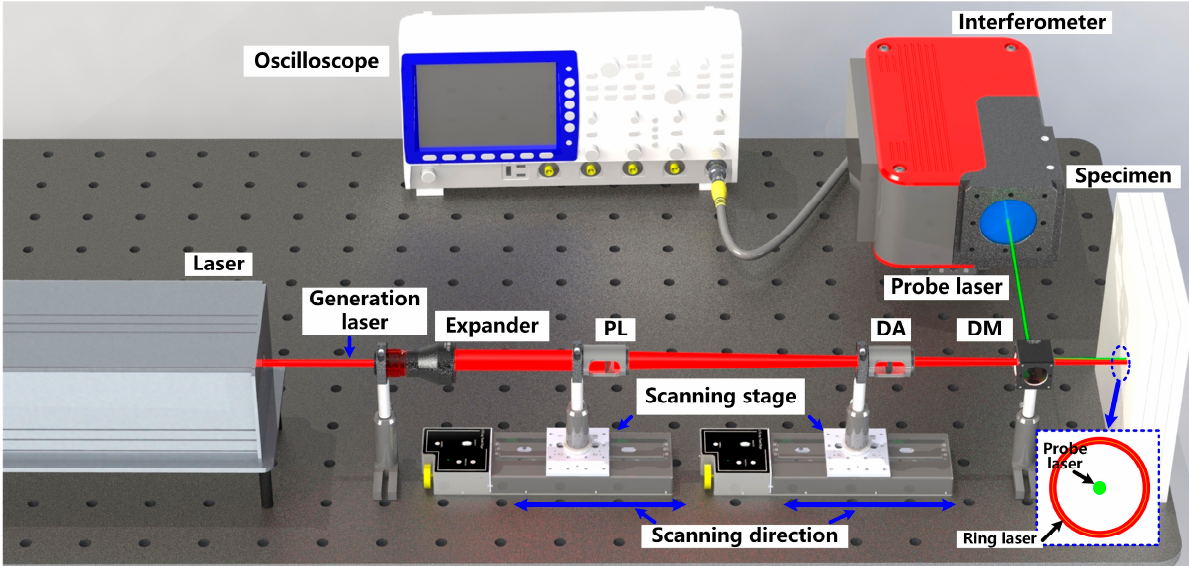
Figure 2. Schematic diagram of RLUT system for thickness measurement.